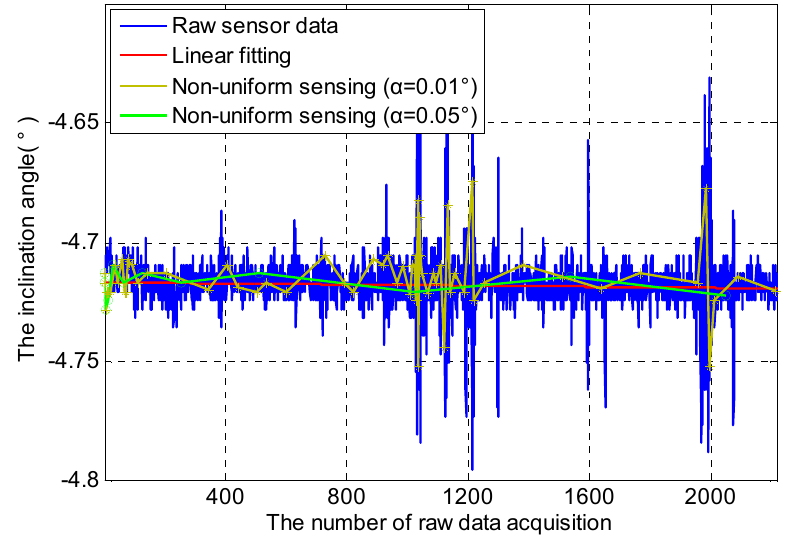
Figure 6. Non-uniform sensing with cooperative TDSS in Scenario A in a short-term span.